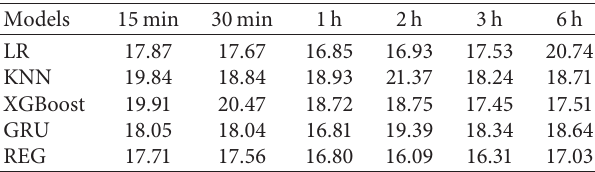
Table 3: Multimodel MAE comparison table for different step sizes.